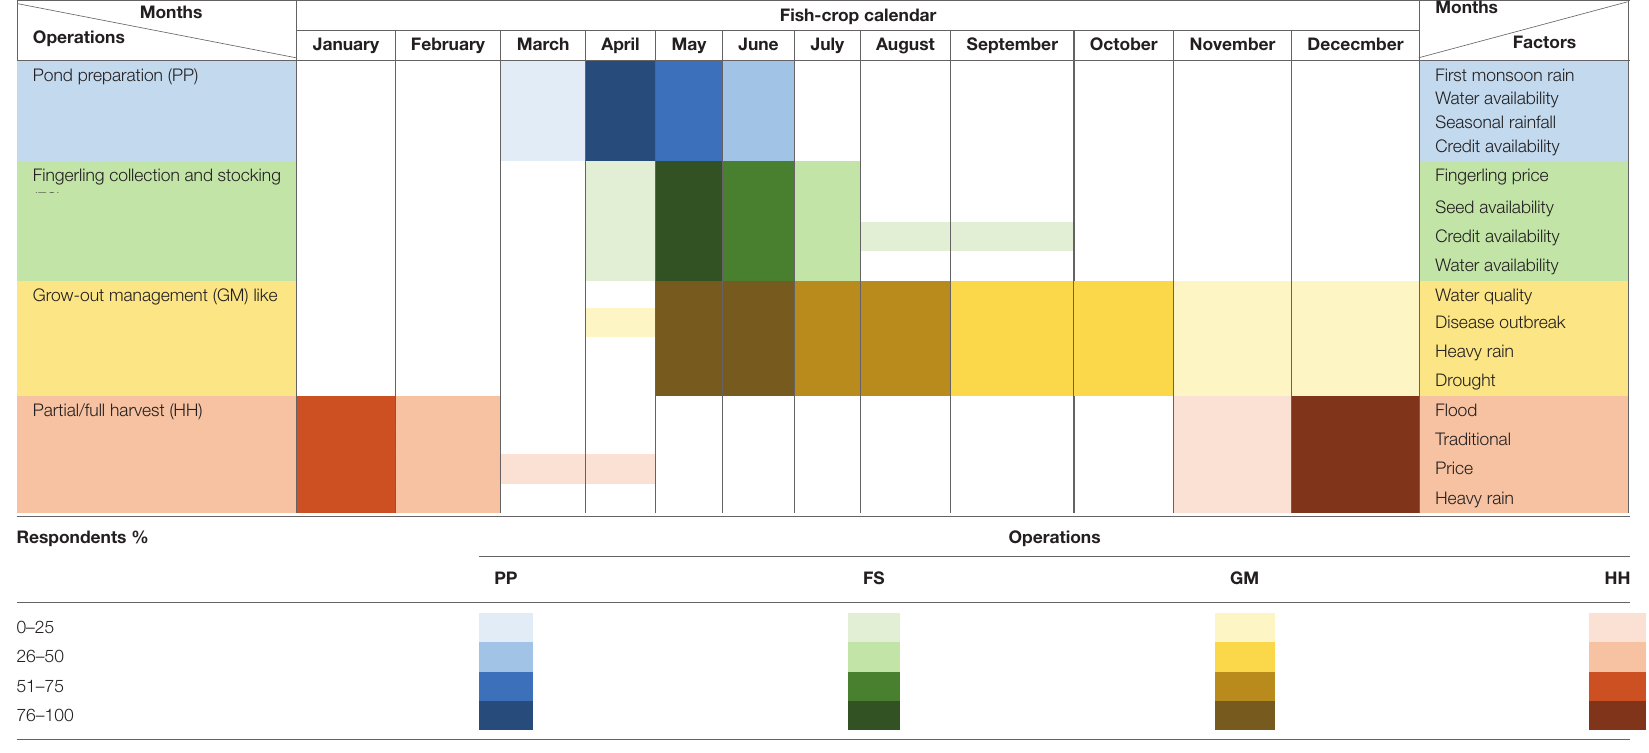
TABLE 2 | Fish-crop calendar in study districts considering factors identified by farmers as contributing to operational and management decisions in the 2018 production season.